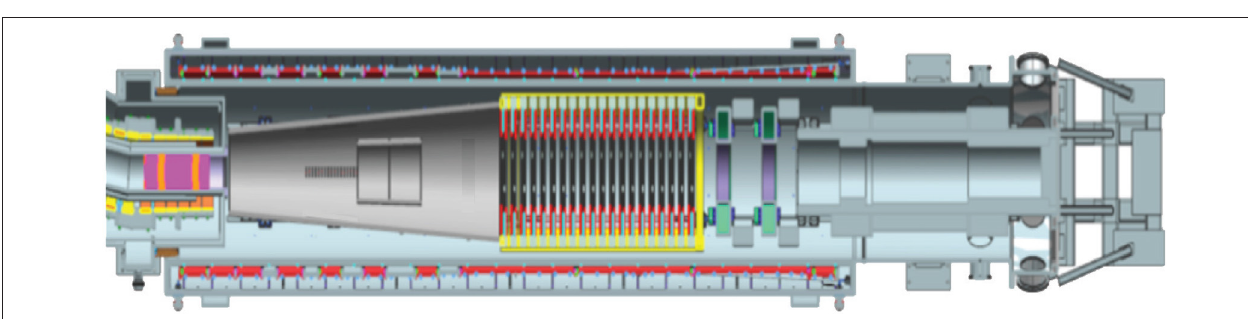
Frontiers in Physics |